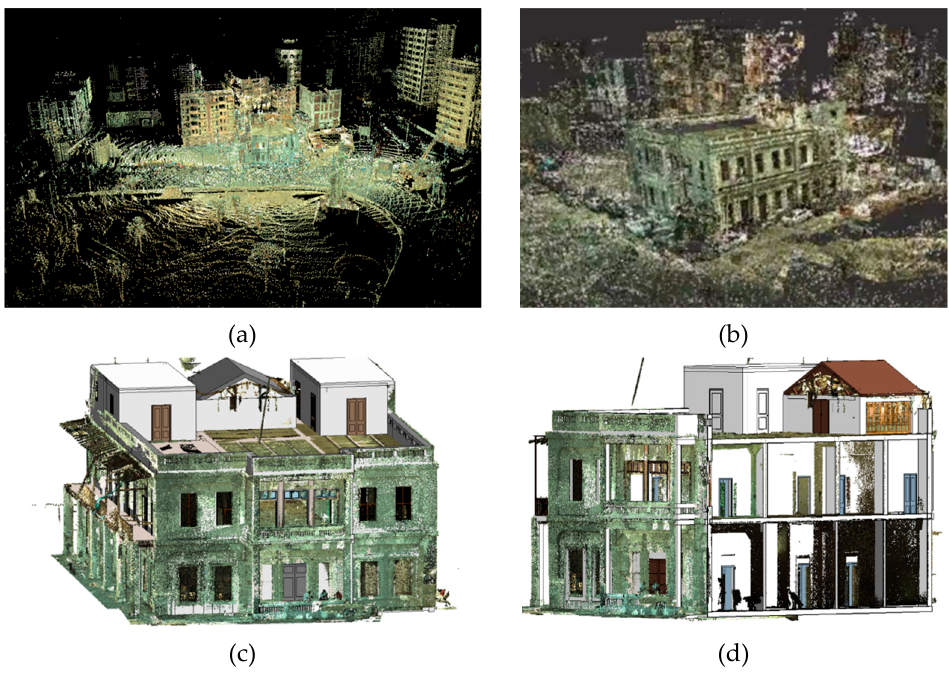
Figure 11. A 3D point cloud model of the building seen in ( a ) and ( b ), which is then linked and modeled in Autodesk Revit software as ( c ) and ( d ).